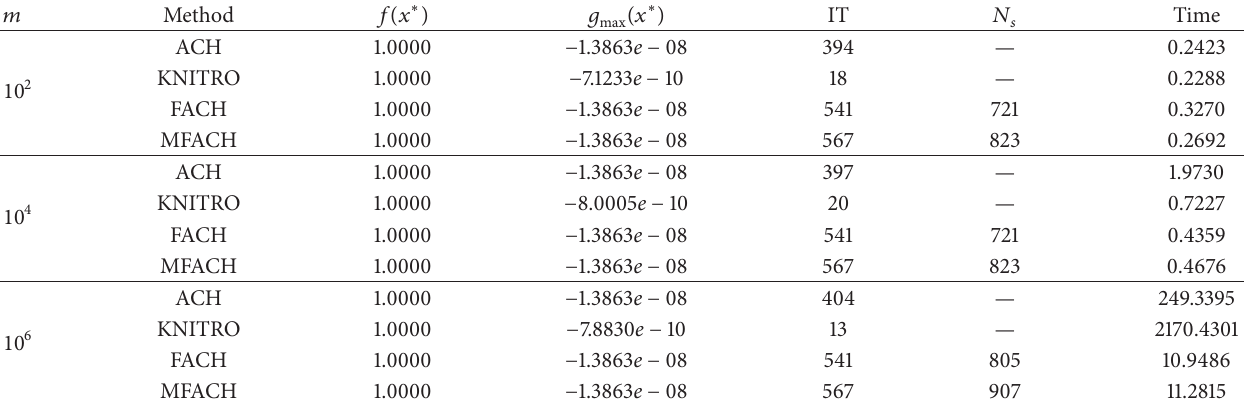
Table 2: Test results for Example 16.